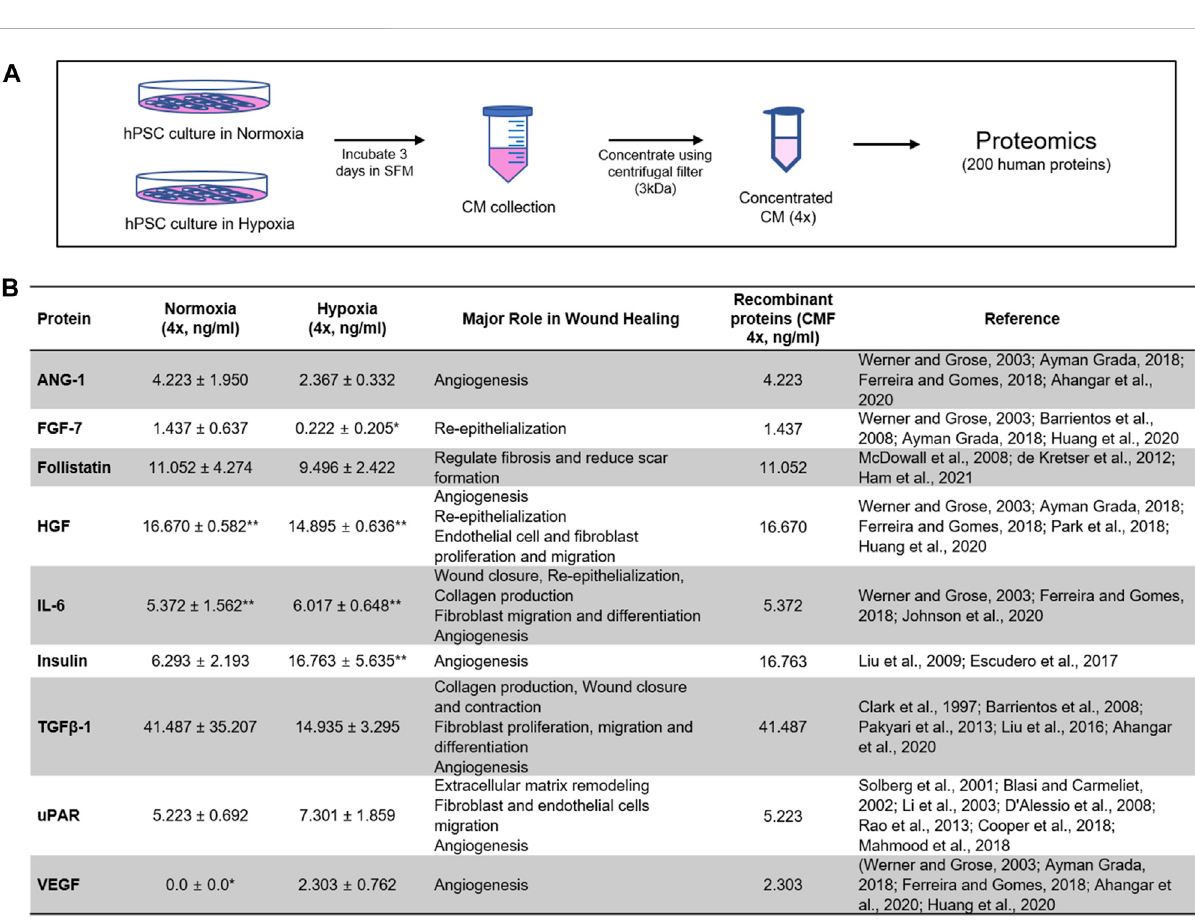
FIGURE 1 Proteomics analysisofstemcell-derivedsecretome.Identi fi cationofhighly expressedhumanproteinsbyproteomicsofhumanplacentalstem cell (hPSC)-derived conditioned medium (CM) in normoxia (21% O 2 ) and hypoxia (1% O 2 ). (A) CM collected from 3-day hPSC culture in serum-free medium (SFM) is concentrated 4× with 3 kDa centrifugal unit, and 200 human proteins are evaluated with proteomics analysis ( n = 3). (B) Nine proteins highly expressed in normoxia and hypoxia with major roles in wound healing are identi fi ed. The composition of recombinant proteins [condition medium factor (CMF 4×)] for wound healing applications. *LOD (value below the limit of detection), **MAX (value above the highest standards). ANG-1: Angiopoietin-1; FGF-7: Fibroblast growth factor-7; HGF: Hepatocyte growth factor; IL-6: Interleukin-6; TGF β -1: Transforming growth factor beta-1; uPAR: Urokinase receptor; VEGF: Vascular endothelial growth